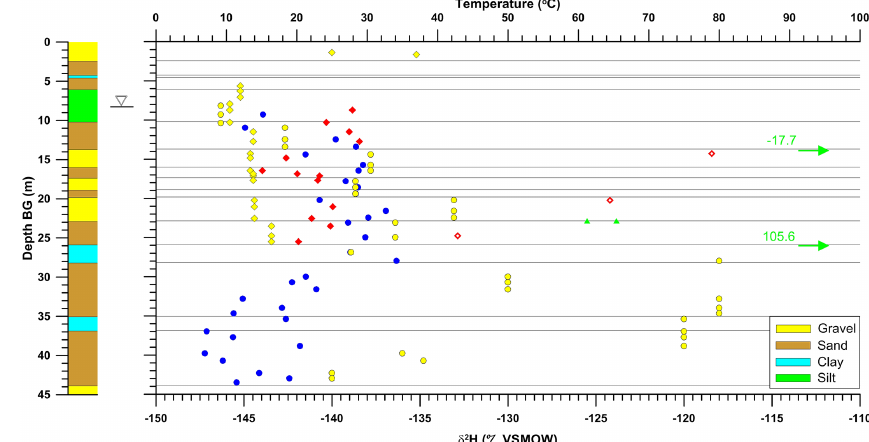
Figure 5. δ 2 H depth profiles of pore water from a complex, saturated natural geologic media located in the Elk Valley, British Columbia. Val- ues for samples collected via dry sonic coring are represented by solid blue circles, via wet sonic and not showing evidence of contamination (or minimally so) are represented by solid red diamonds, and via wet sonic and visibly contaminated by drill fluid are represented by open red diamonds. The δ 2 H values of the drill fluid samples are represented by solid green triangles. The temperatures of the core upon extraction are represented by solid yellow circles and solid yellow diamonds for the dry sonic and wet sonic samples, respectively. The location of the water table is identified by an inverted triangle. The mean gravimetric water content of samples from adjacent wet and dry sonic core samples from the complex saturated natural site were 9.9 ± 5.1% ( n = 19) and 12.6 ± 5.1% ( n = 34), respectively.